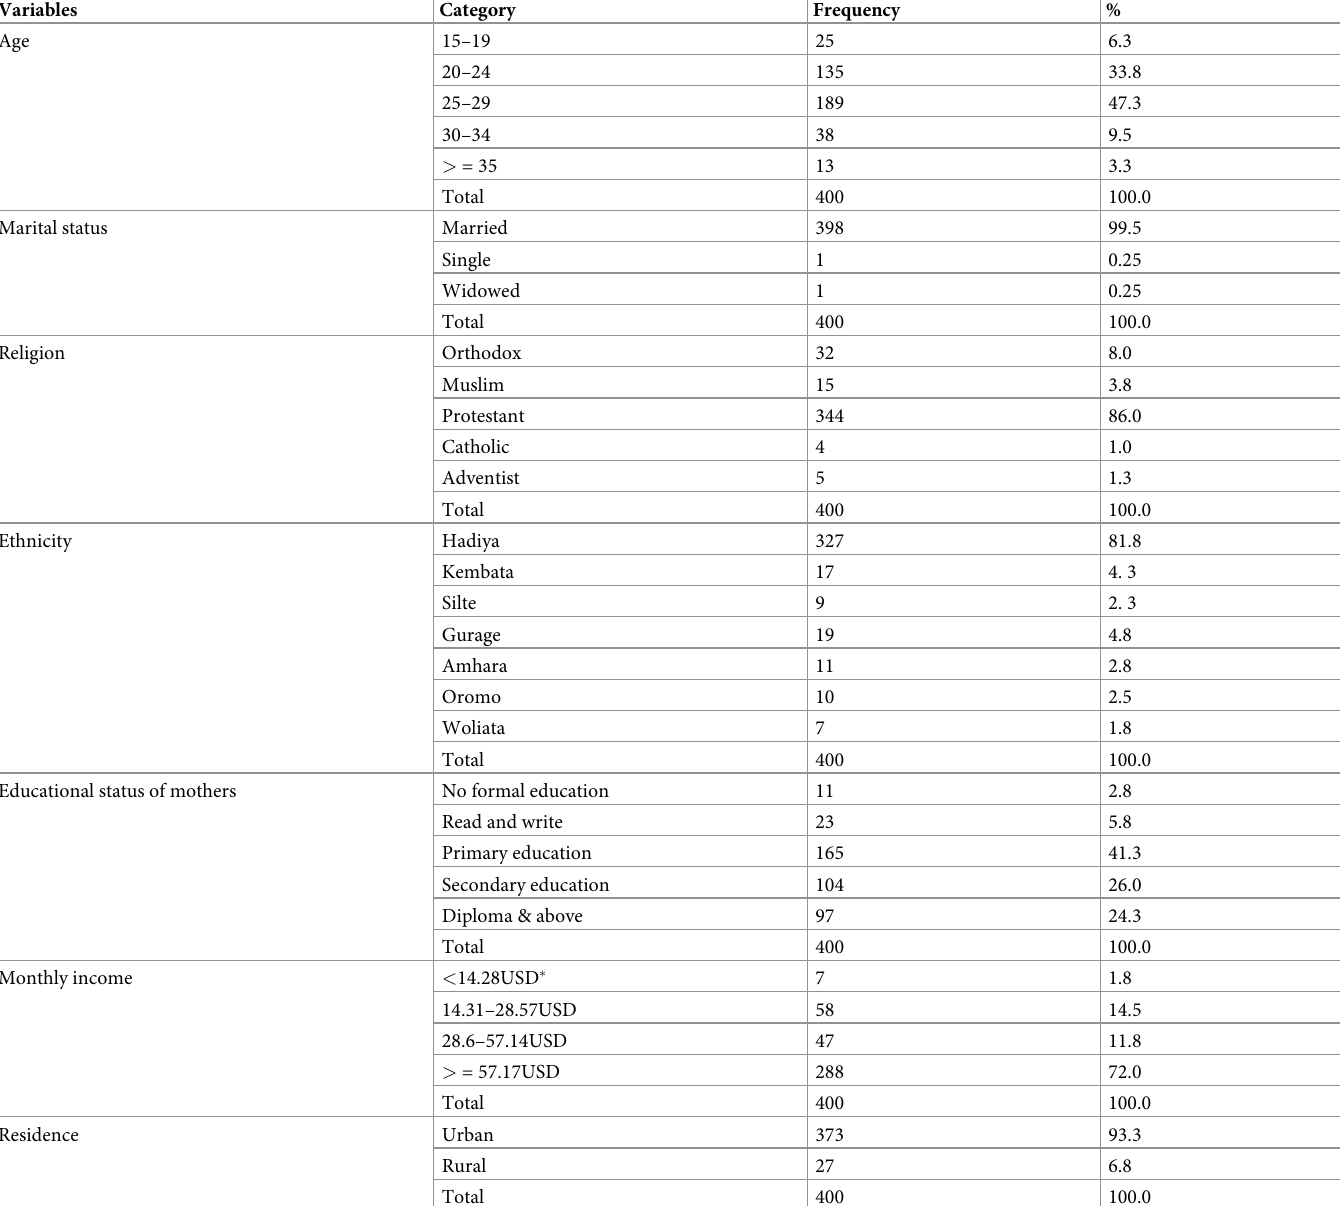
Table 1. Socio-demographic characteristics of women attending antenatal care clinics of public health facilities in Hossana town, Southern Ethiopia, 2020 (n =